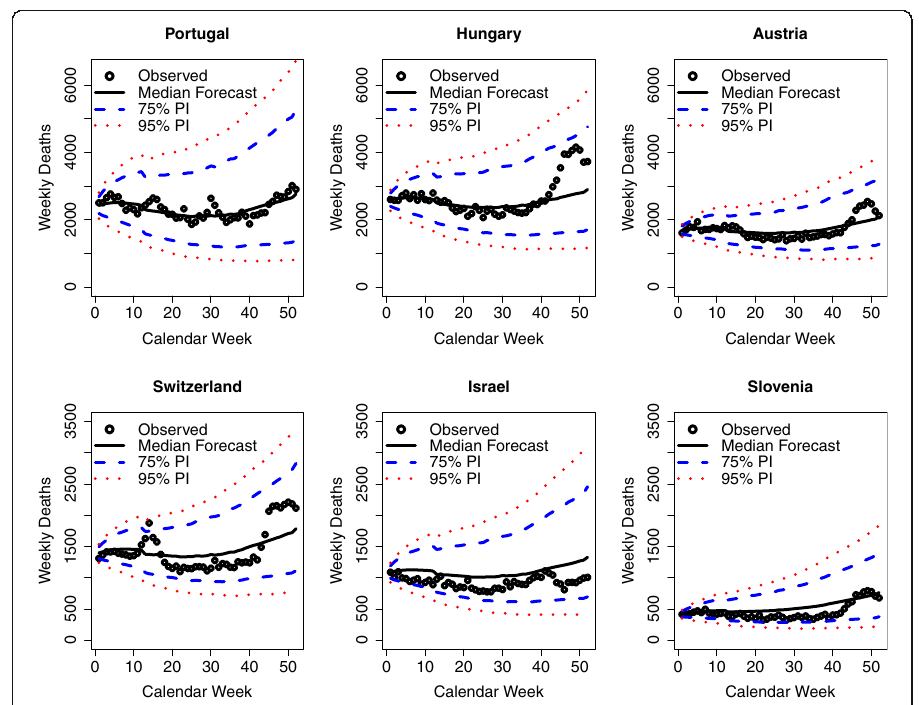
Fig. 9 Observed and predicted weekly deaths in 2020 by country for the remaining countries without statistically significant excess mortalities. Sources: Human Mortality Database (2021); Computations and design by the